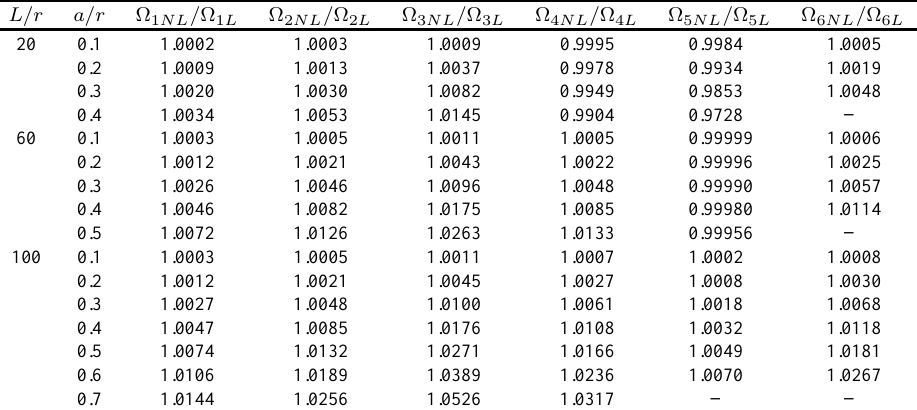
Table 3 Ratio of nonlinear frequencies to linear frequencies for clamped